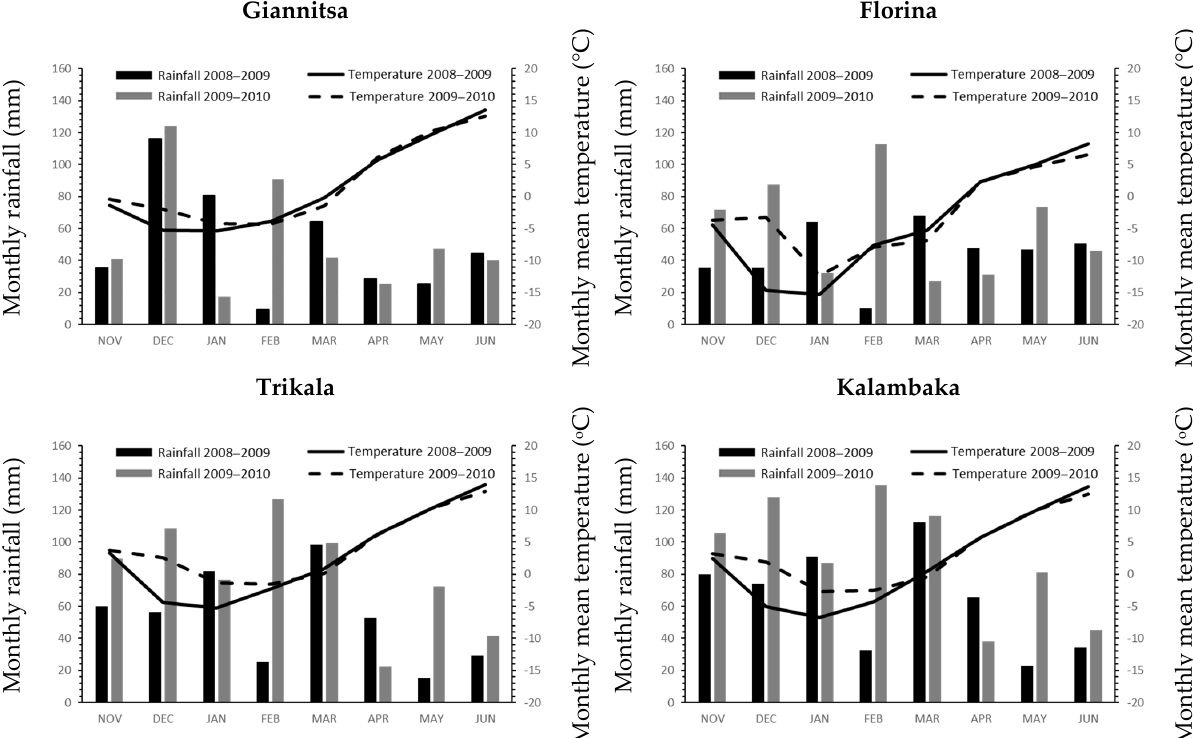
Figure 1. Basic weather data (mean monthly temperature in °C and rainfall in mm) based on daily records, through two